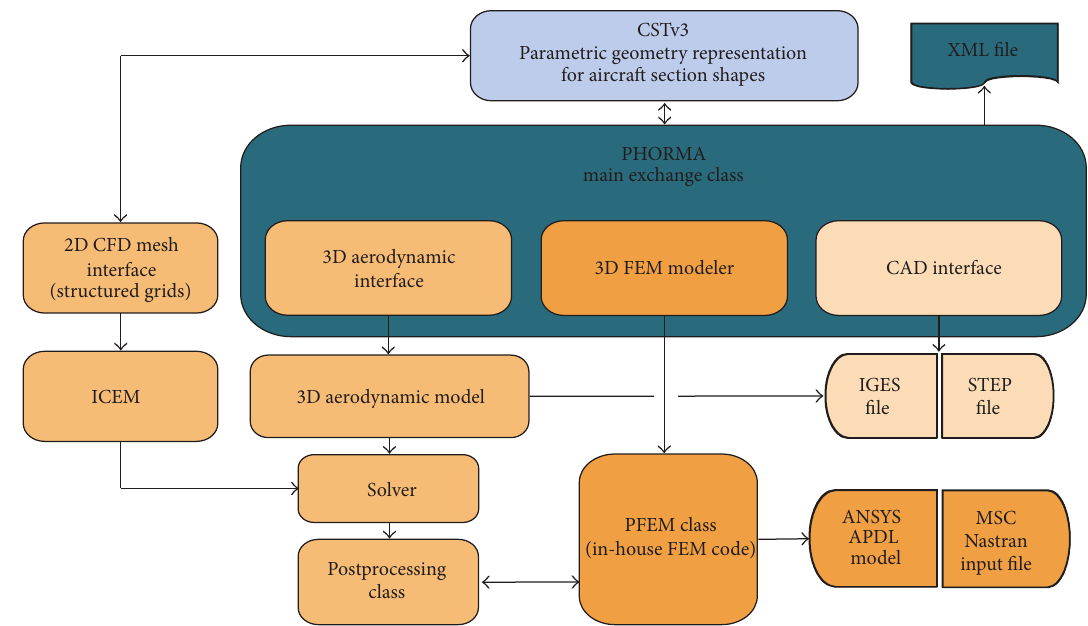
Figure 2: The parametric